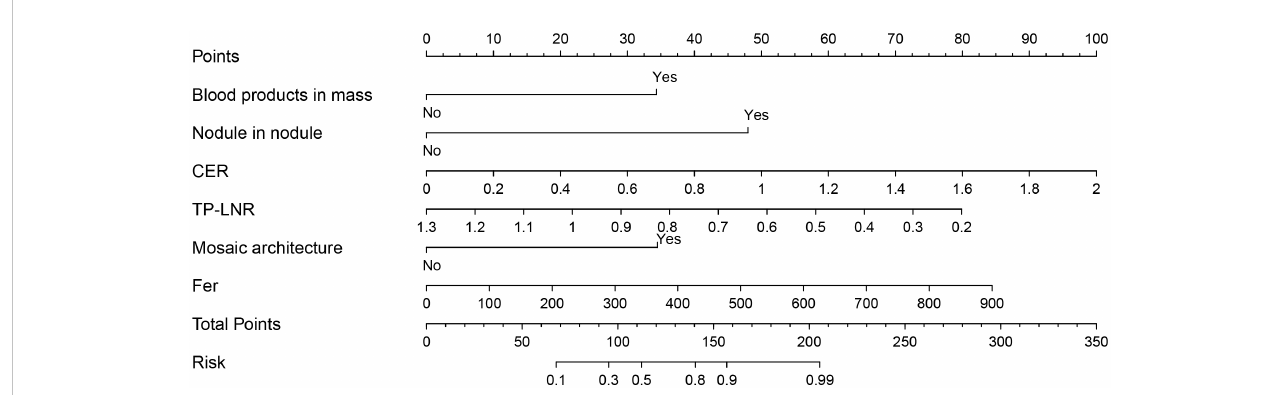
FIGURE 3 Nomogram constructed based on LI-RADS features, quantitative contrast-enhanced MRI parameters and clinical indicators for predicting GPC-3 expression. According to whether each patient had the features of blood products in mass, nodule-in-nodule architecture and mosaic architecture as well as the CER, TP-LNR, and Fer levels, for a total of 6 indicators, vertical lines can be drawn between each indicator and the nomogram points to obtain the value of each indicator. Then, the total score can be obtained by adding the scores of the 6 indicators; fi nally, a vertical line can be drawn between the total score and the nomogram total risk to predict the probability of positive GPC-3 expression in patients.